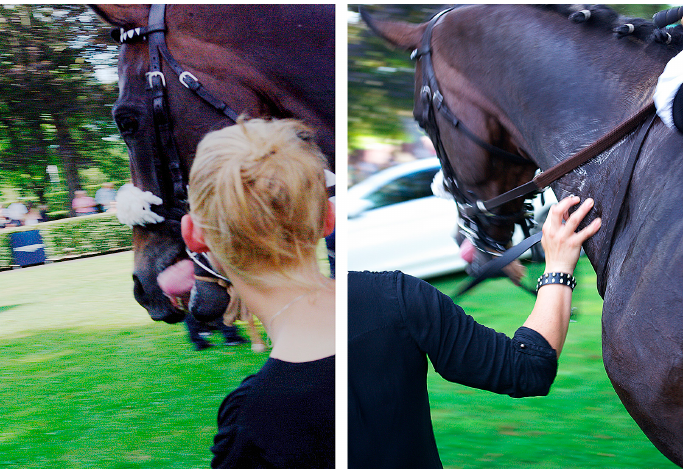
Figure A3. Images 7 and 8 of eight images of a thoroughbred with a tongue-tie taken on race day while the horse was led past the photographer/researcher in the mounting yard.